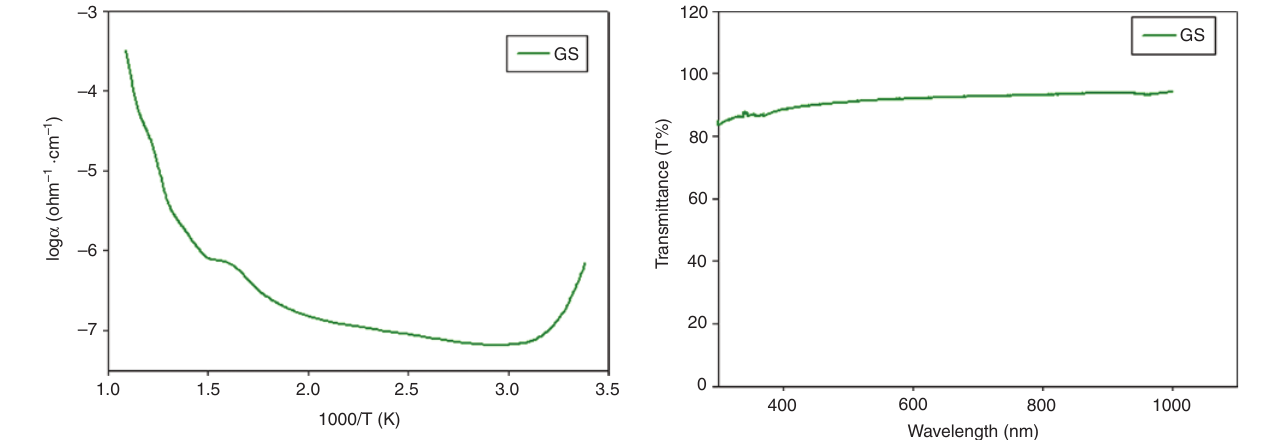
Figure 6: Optical transmittance graph for GS zinc oxide nanoparti- cles (ZnO-NPs)